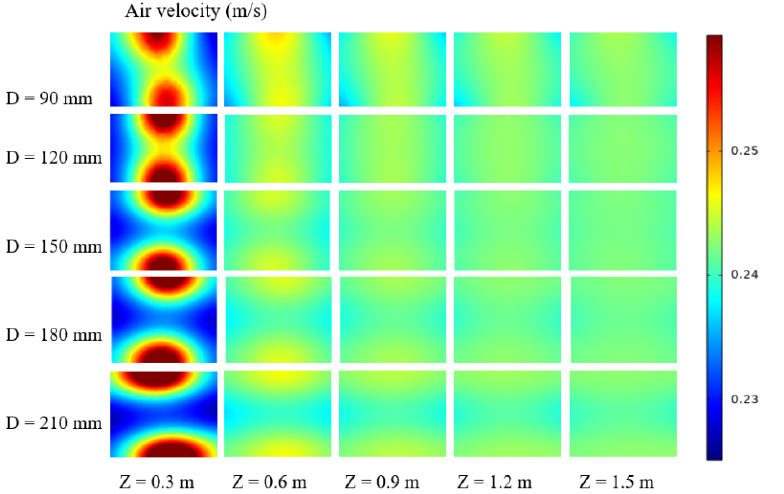
Figure 13. Cloud map of the air velocity variation along the horizontal direction at different orifice spacings.